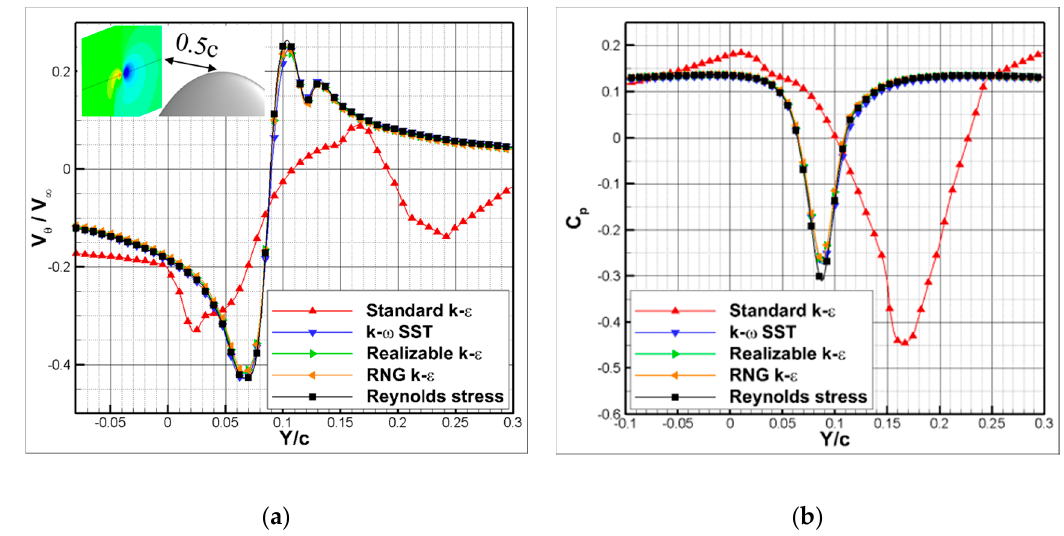
Figure 13. Comparison of distributions of ( a ) non-dimensional tangential velocity and ( b ) pressure coefficient predicted using different turbulence models on the line passing through the vortex core in a plane 0.5c downstream from wing-tip.